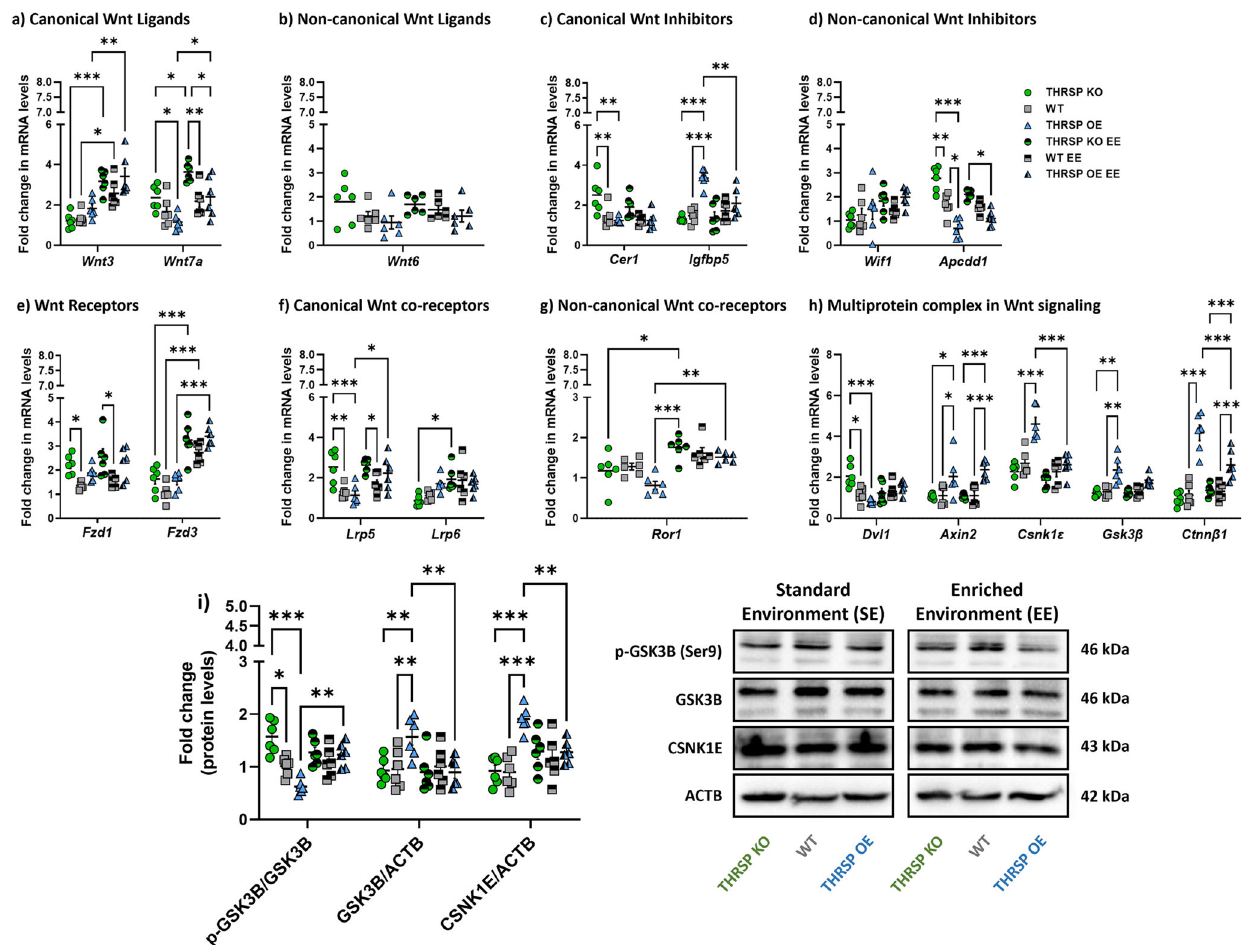
Fig. 8 Expression of hippocampal DG Wnt pathway elements after environmental enrichment and treadmill exercises. qRT-PCR analyses of a canonical and b noncanonical Wnt ligands ( n = 6 mice/group; a two-way ANOVA, Strain: F ( 5, 60 ) = 17.0, P < 0.001, Gene targets: F ( 1, 60 ) = 0.0245, P = 0.876; Strain × Gene targets: F ( 5, 60 ) = 4.51, P = 0.001; b one-way ANOVA, F ( 5, 30 ) = 1.82, P = 0.139), the c canonical and d noncanonical Wnt inhibitors ( n = 6 mice/group; a two-way ANOVA, Strain: F ( 5, 60 ) = 4.35, P = 0.002, Gene targets: F ( 1, 60 ) = 5.72, P = 0.020; Strain × Gene targets: F ( 5, 60 ) = 4.51, P < 0.001; b two-way ANOVA, Strain: F ( = 5.18, P < 0.001, Gene targets: F ( = 1.63, P = 0.207; Strain × Gene targets: F ( = 11.1, P < 5, 60 ) 1, 60 ) 5, 60 )